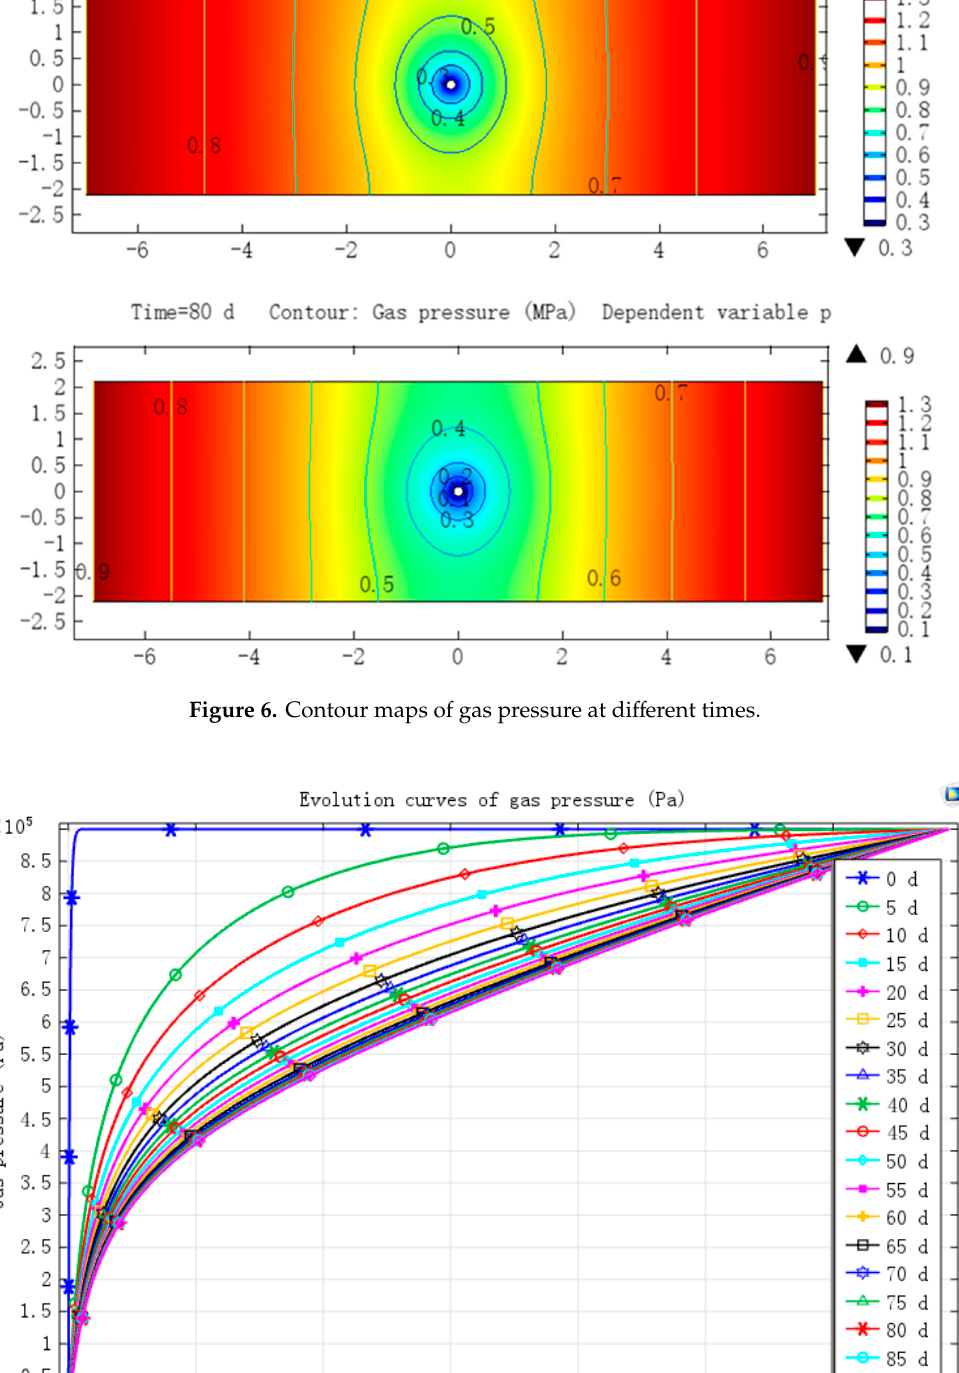
Figure 8. Evolution curves of porosity.